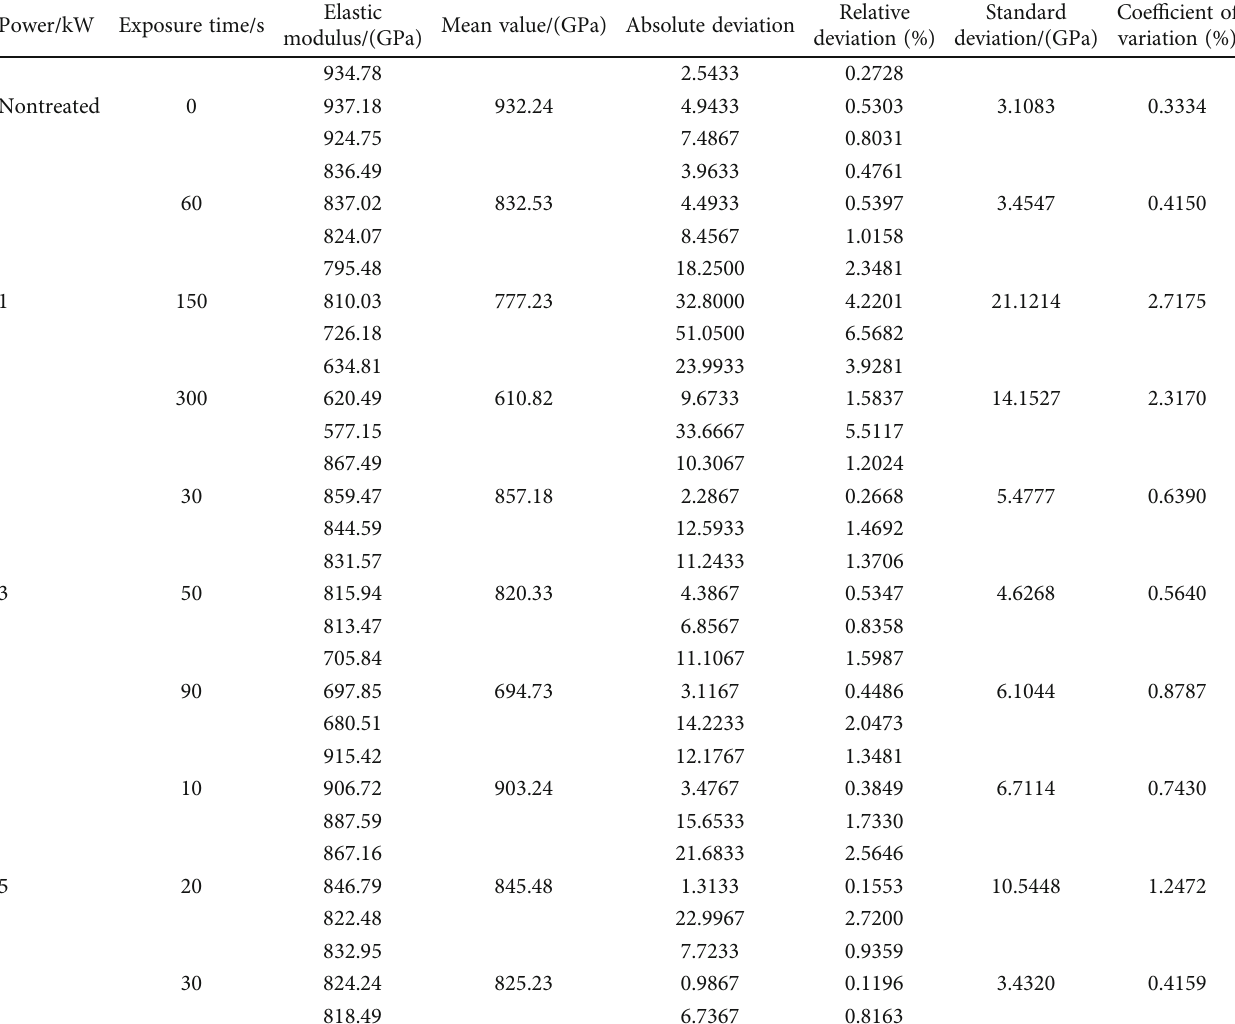
Table 5: Testing results of elastic modulus induced by microwave